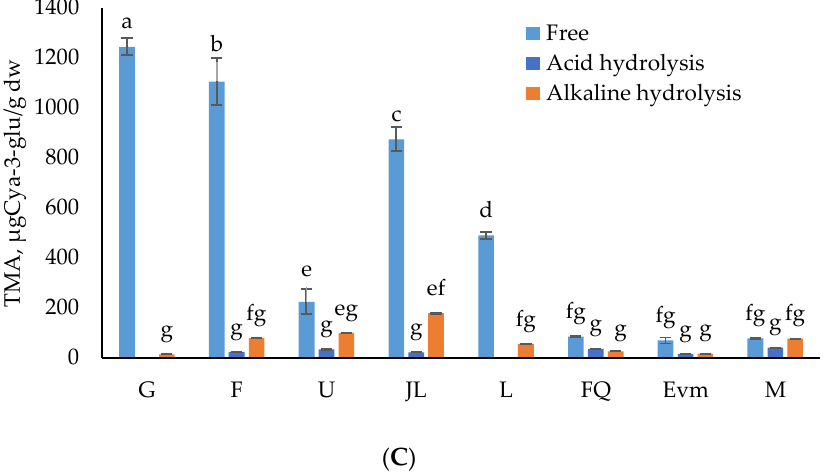
Figure 1. Free and bound (insoluble) phenolics content distribution of eight peach varieties’ peel extracts—( A ) Total phenolic content (TPC, mgGAE/g dw), ( B ) Total flavonoids (TFC, µgQE/g dw) and ( C ) Total monomeric anthocyanins (TMA, µg cyanidin-3-glucoside (C3GE)/g dw). G—“Gergana”, F—“Filina”, U—“Ufo 4”, JL—“July Lady”, L—“Laskava”, FQ—“Flat queen”, Evm—“Evmolpiya”, M—“Morsiani 90”. Different letters (a–l) within chart columns indicate signifi- cant differences ( p < 0.05) between treatments as analyzed by two-way ANOVA and the Tukey test (n = 3 per treatment